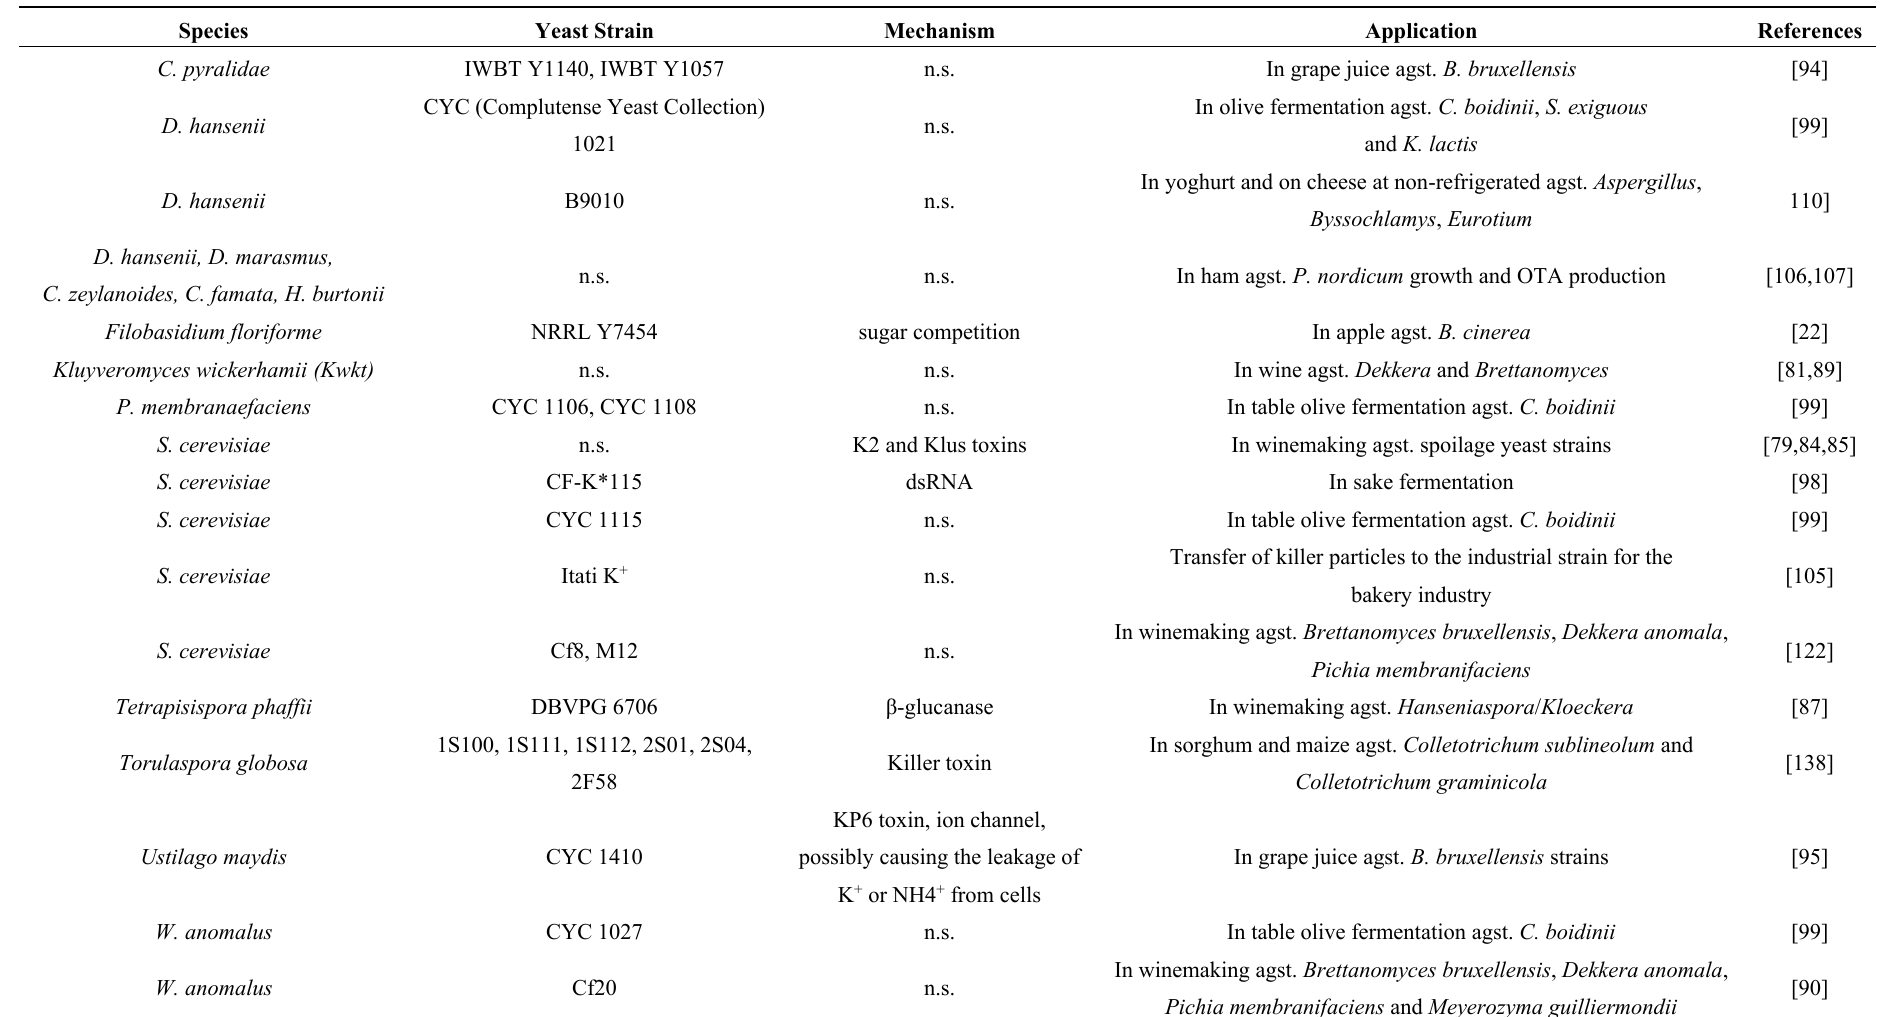
Table 1. Yeast strains and antagonistic mechanisms in processed food and beverage